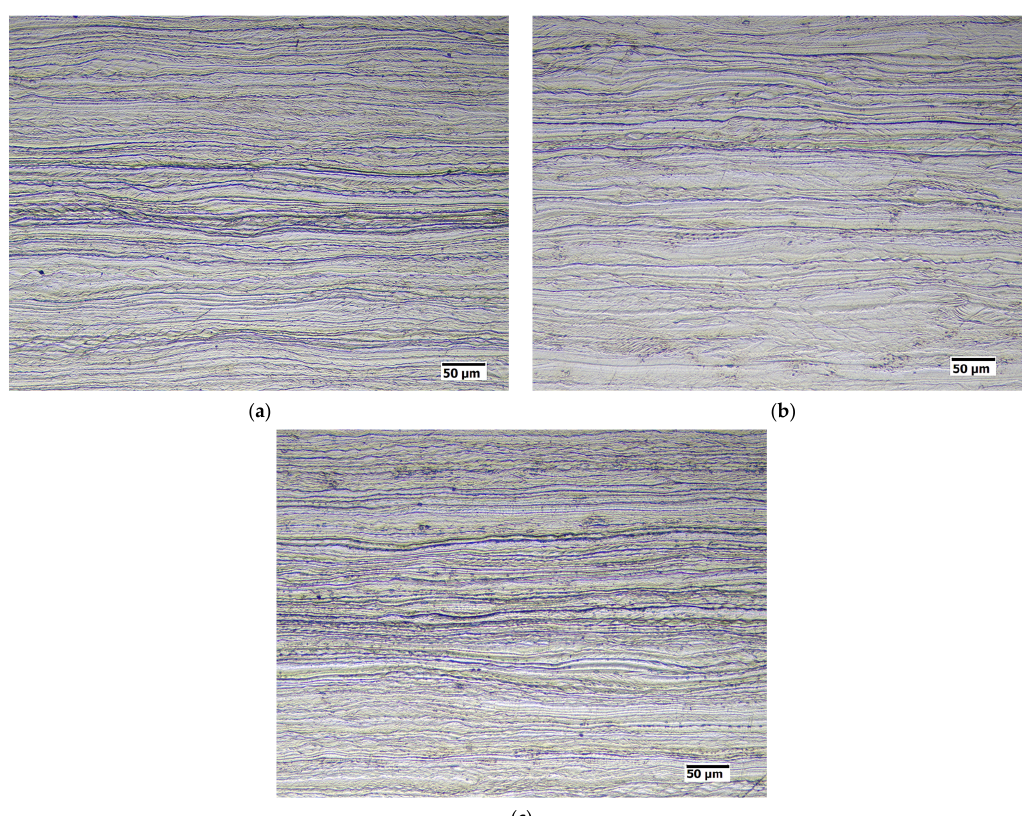
Figure 2. AISI 904L cold-rolled steel. ( a ) CR: 50%; ( b ) CR: 70%; ( c ) CR: